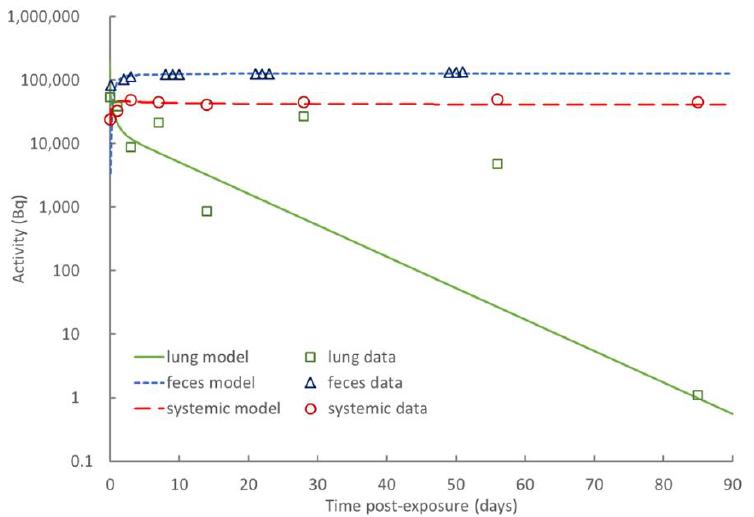
Figure 6. Fit of rat biokinetic model to experimental data.